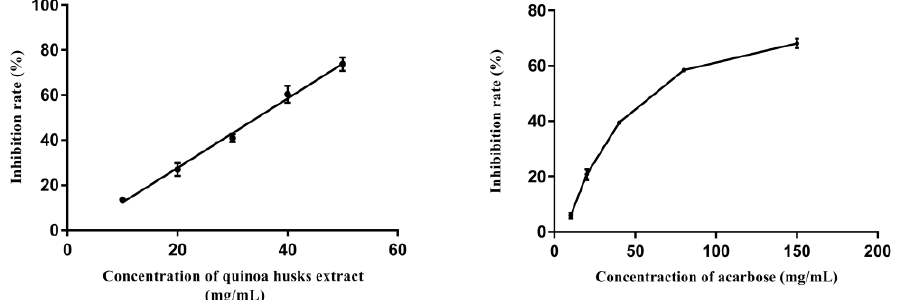
Figure 5. Inhibitory effect of the quinoa husk extracts and acarbose on α -glucosidase at different concentrations.